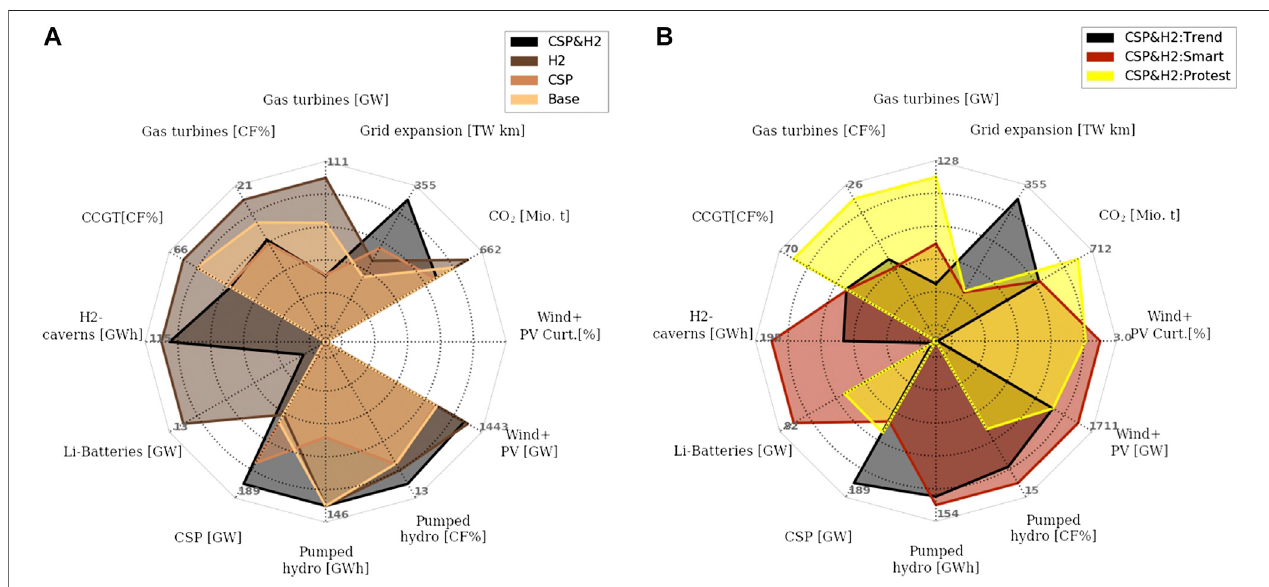
FIGURE 6 | Key indicators for technology scenarios (left) and grid scenarios (right) for 85% CO 2 reduction targets.